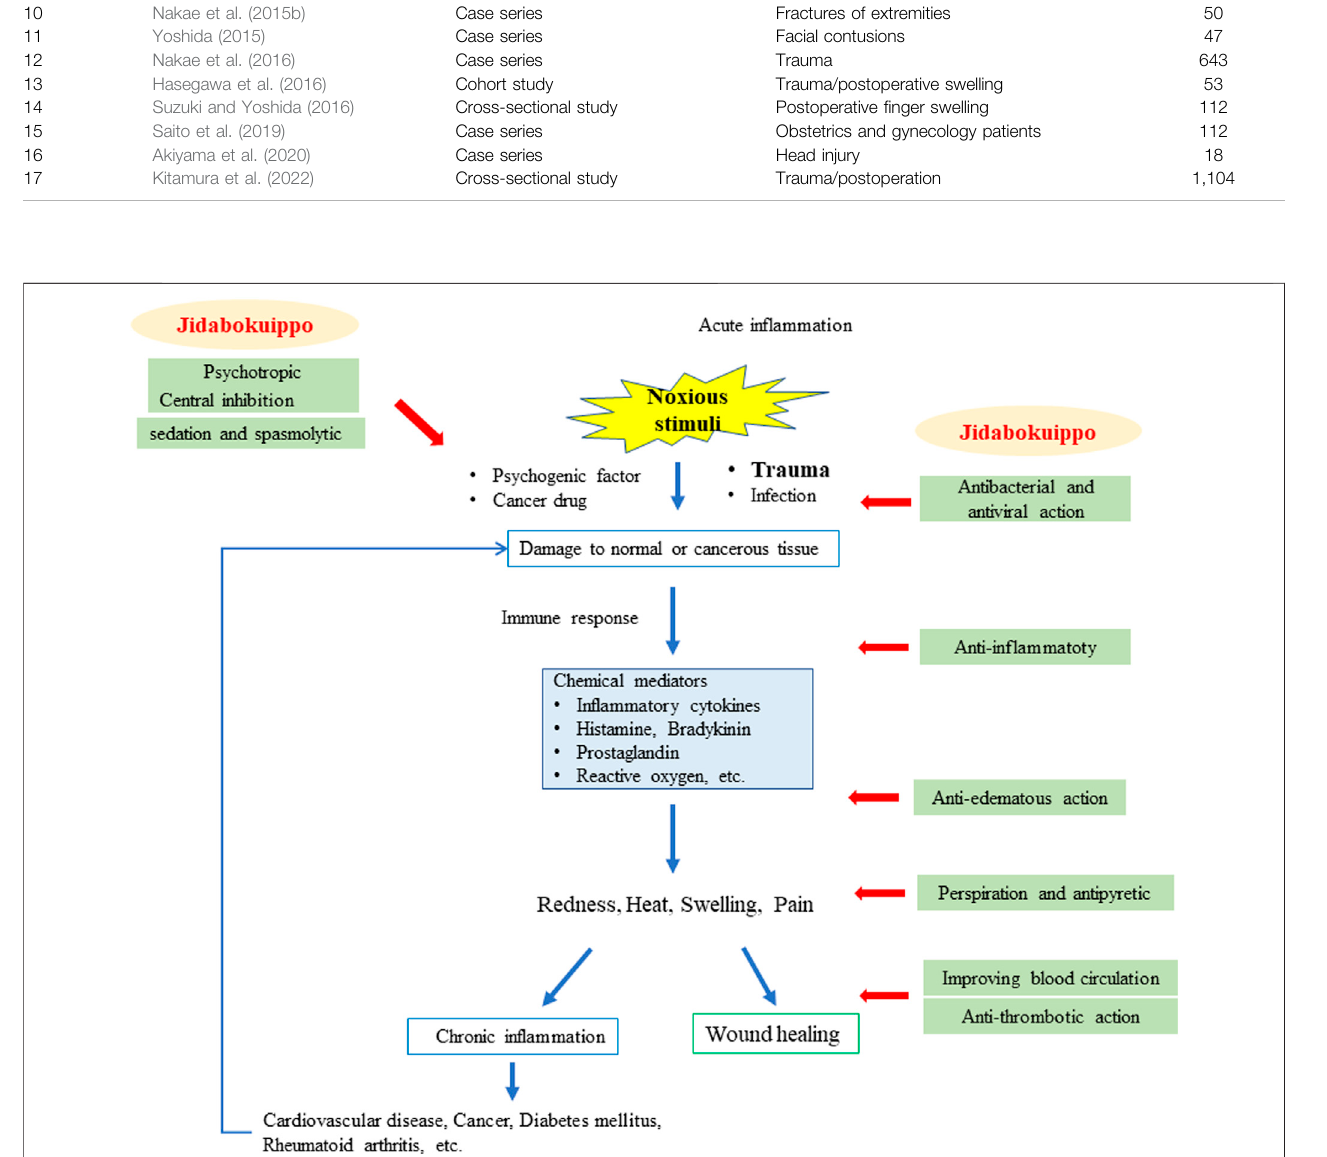
Frontiers in Pharmacology |